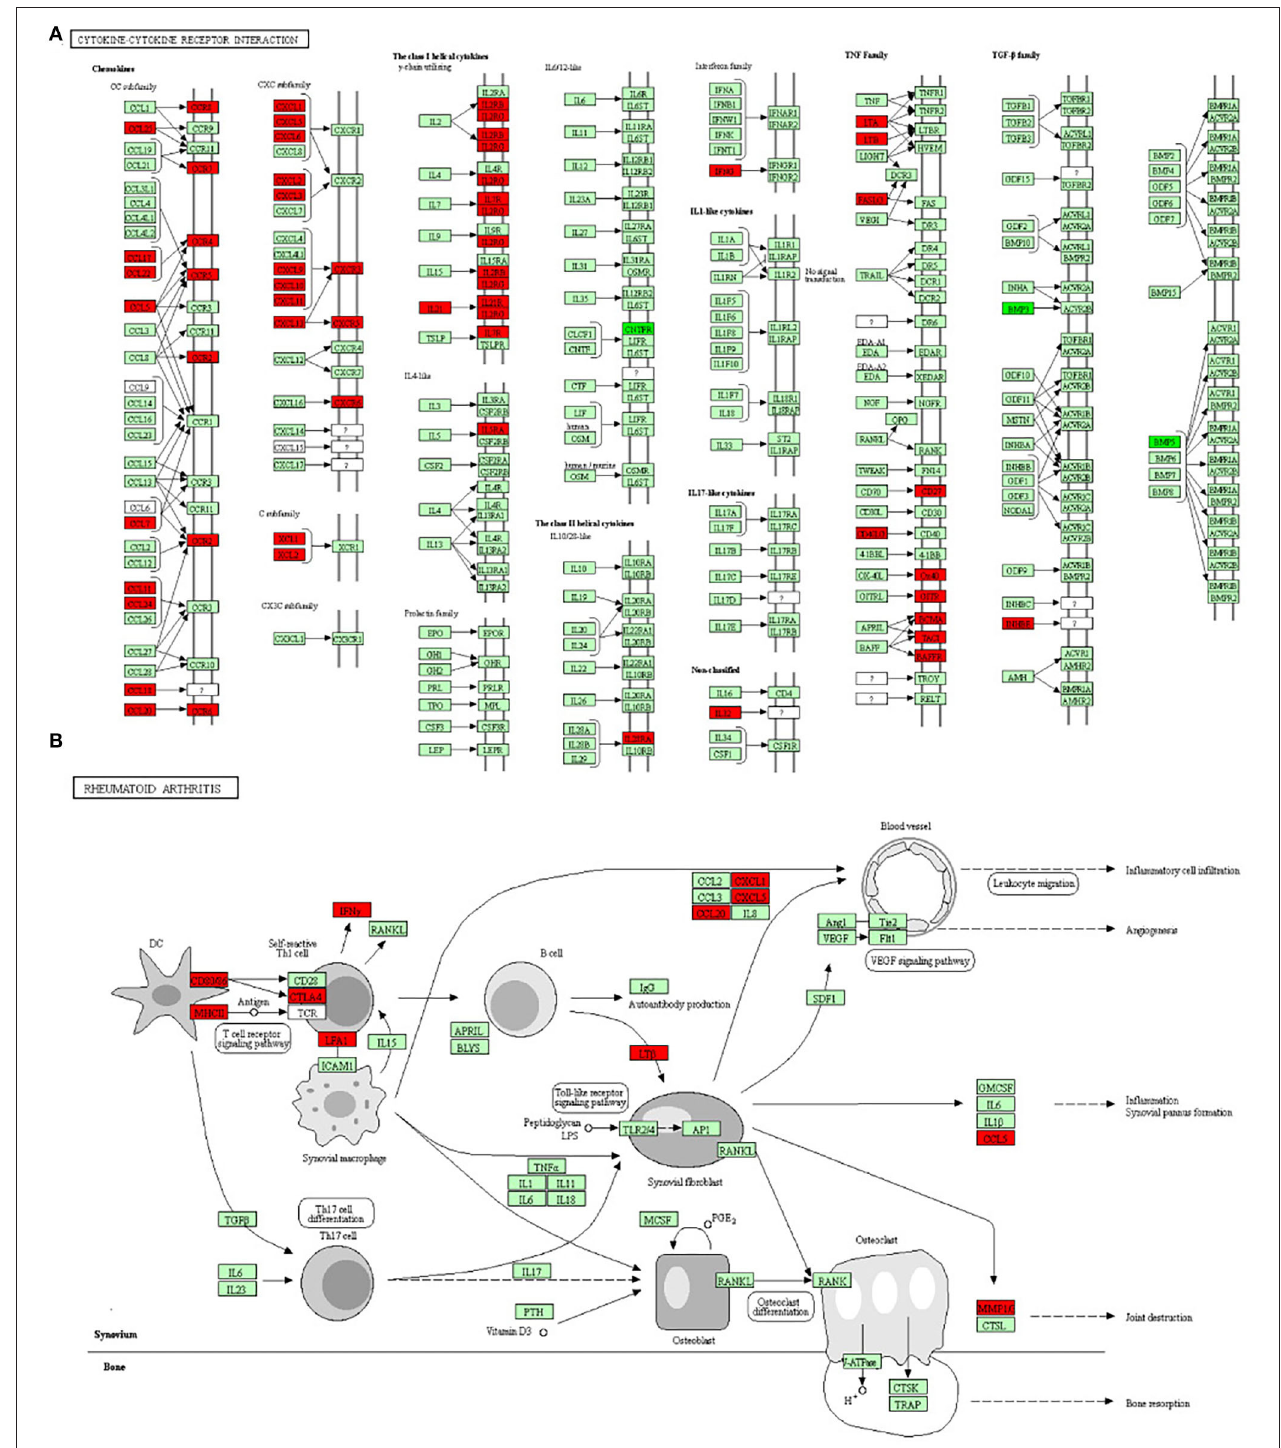
FIGURE 4 | The two most important pathways identified through the KEGG pathway analysis. (A) The cytokine–cytokine receptor interaction pathway and (B) the rheumatoid arthritis pathway. The red boxes represent upregulated genes and the dark green boxes represent downregulated genes. the pathways, gene networks, and hub genes. In this study, OA synovial tissue samples of patients with RA, we collected the was used as the control group to study RA biomarkers. We samples from patients with RA and OA present at the same performed transcriptomic analysis of the synovial tissue rheumatology hospital, performed RNA-seq, and investigated